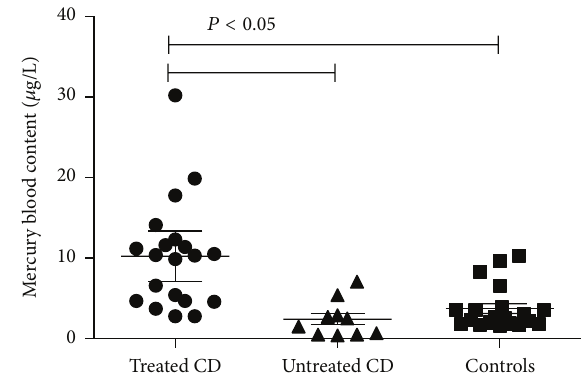
Figure 1: Mercury (Hg) blood levels of untreated and treated celiac (CD) patients and healthy controls. Mean, 95% confidence intervals, and statistical significance are reported in the